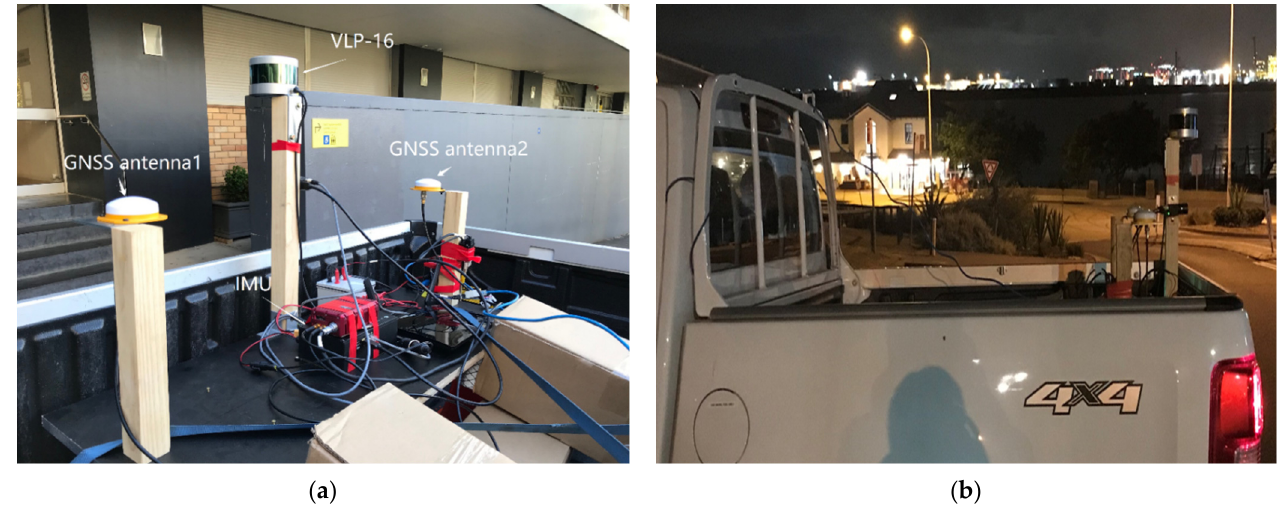
Figure 5. Experimental platform: ( a ) The multi-sensor system, ( b ) side view of the system installed within a vehicle.